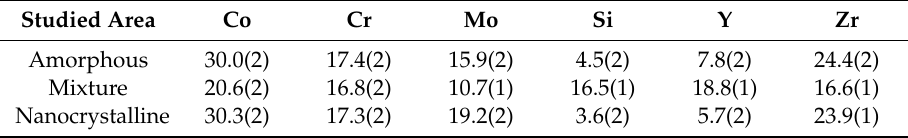
Figure 4. Bright field image of the amorphous area ( a ) with corresponding selected area electron di ff raction (SAED) pattern ( b ), bright field of the amorphous area (red circle) ( c ) with corresponding SAED pattern ( d ), bright field of a mixture of amorphous and nanocrystalline area (blue circle) ( c ) with corresponding SAED pattern ( e ), high-resolution image nanocrystalline area ( f ) with Fourier-transformation image corresponding to HR image ( g ), bright field image of the nanocrystalline area ( h ) with corresponding SAED pattern ( i ), and bright field and dark field images of the amorphous and mixture of amorphous and nanocrystalline areas ( j ). Table 4. TEM EDS chemical composition (at.%) of all phases in the studied alloys.